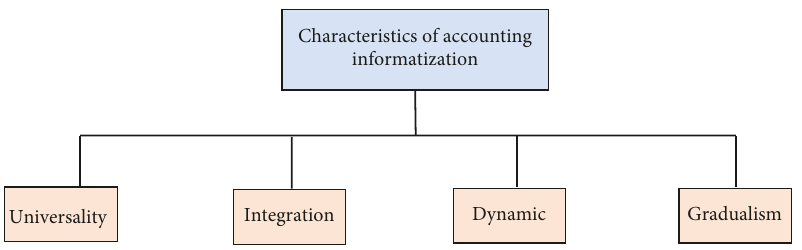
Figure 7: Characteristics of accounting informatization in policy